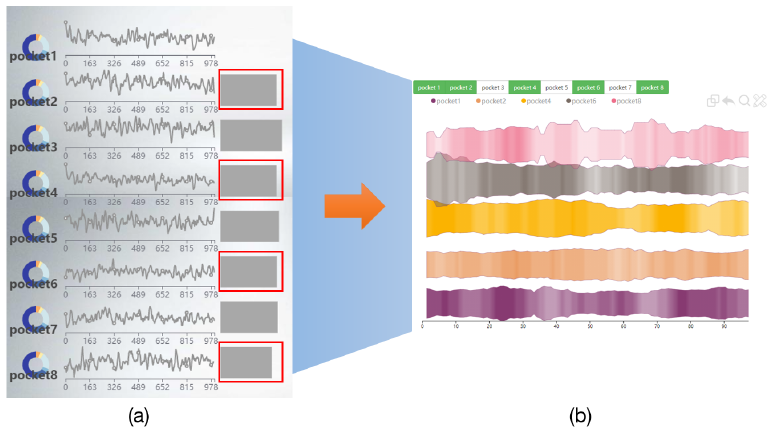
Figure 15. ( a ) The calculated primary pocket profile. ( b ) Automatically extracts the pocket according to the pocket